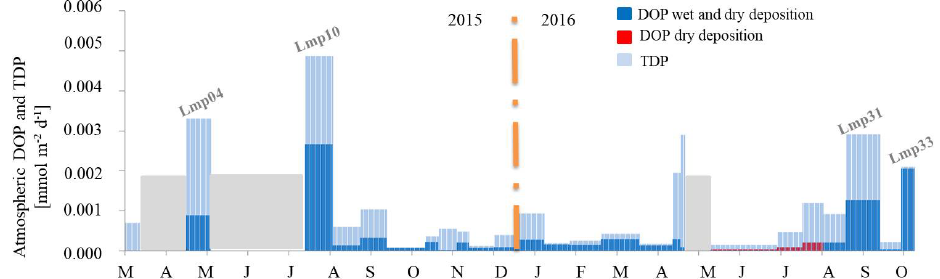
Figure 4. Atmospheric DOP and TDP deposition. Gray areas correspond to the periods with no data. The month abbreviation and tick marks correspond to the end of the corresponding month. The width of the bar refers to the length of the sampling period.